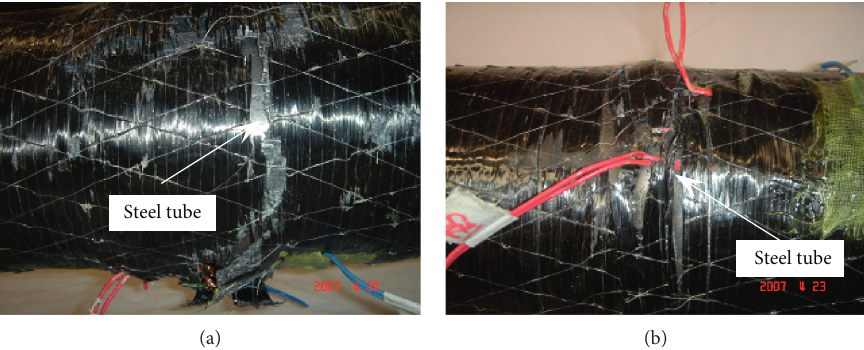
Figure 5: Fracture of CFRP of specimens with a small axial compression ratio. (a) Longitudinal CFRP of A1. (b) Transverse CFRP of A0.